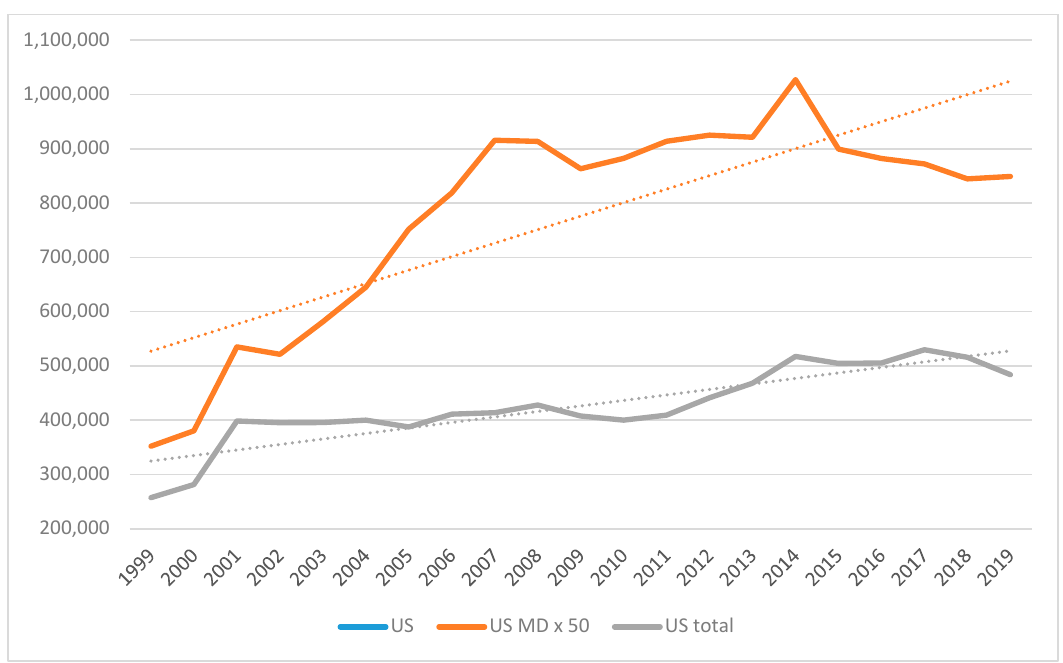
Figure 1. Development of patent application activity in the United States overall and compared with the medical device industry.